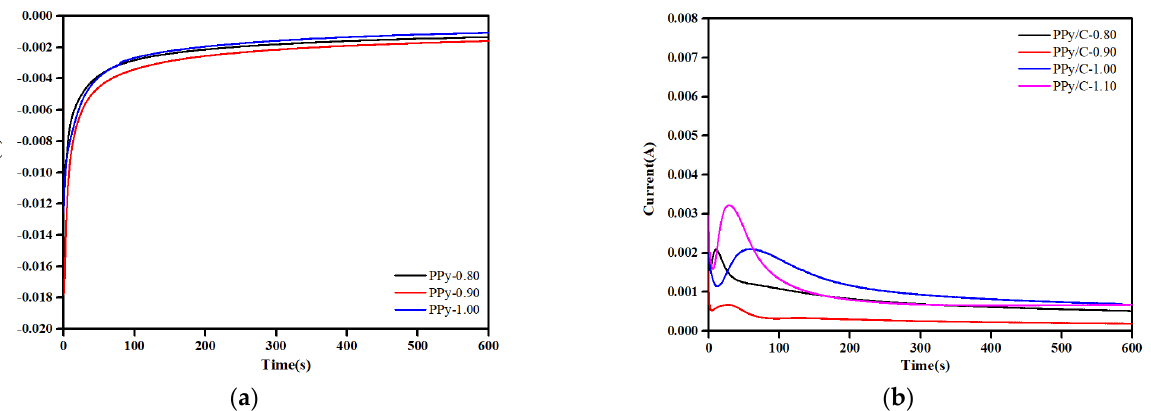
Figure 1. I–t curves for progress of synthesized coatings at different potentials in a magnetically stirred ice bath: ( a ) 0.1 Mpy + 0.3 M oxalic acid solution; ( b ) 0.1 Mpy + 1 g/L graphite powder + 0.3 M oxalic acid solution.